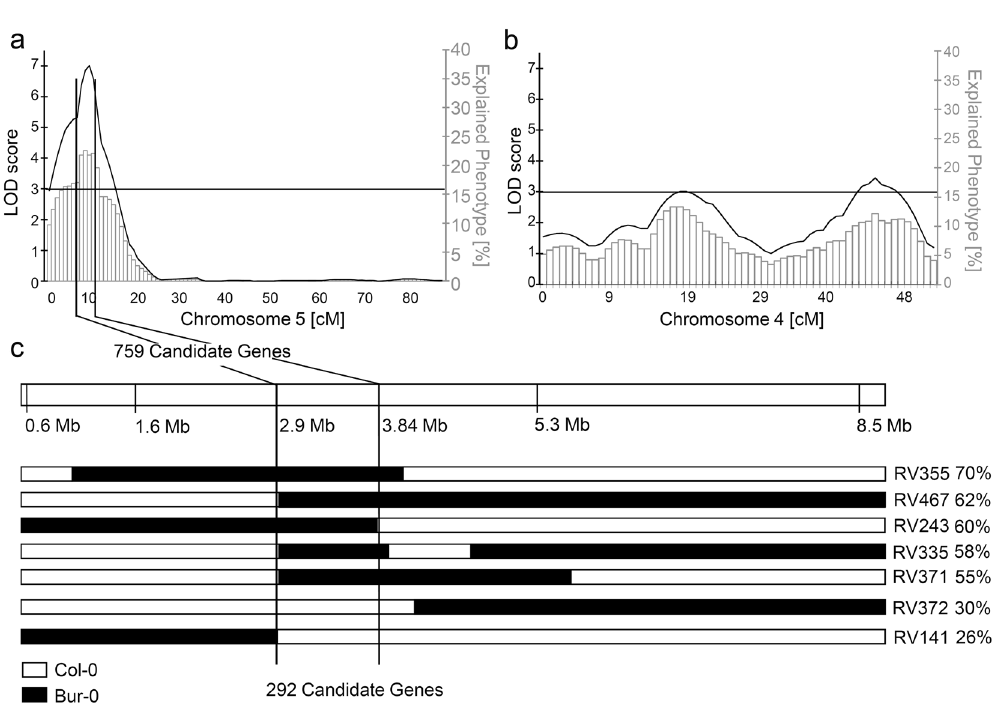
Figure 6. Genetic linkage mapping of loci contributing to variation in Cd tolerance across the Bur-0 × Col-0 RIL population. QTL mapping with MapQTL5 after determination of the relative root growth of 131 RILs at 2 µ M CdCl 2 detected a major QTL on chromosome 5 ( a ) and two minor QTLs on chromosome 4 ( b ). ( c ) Through additional marker analysis the QTL on chromosome 5 was narrowed to an interval located between 2.9 and 4.01 Mb. Indicated are the genotypes (white: Col-0; black Bur-0) and the Cd tolerance (in %RRG) for informative